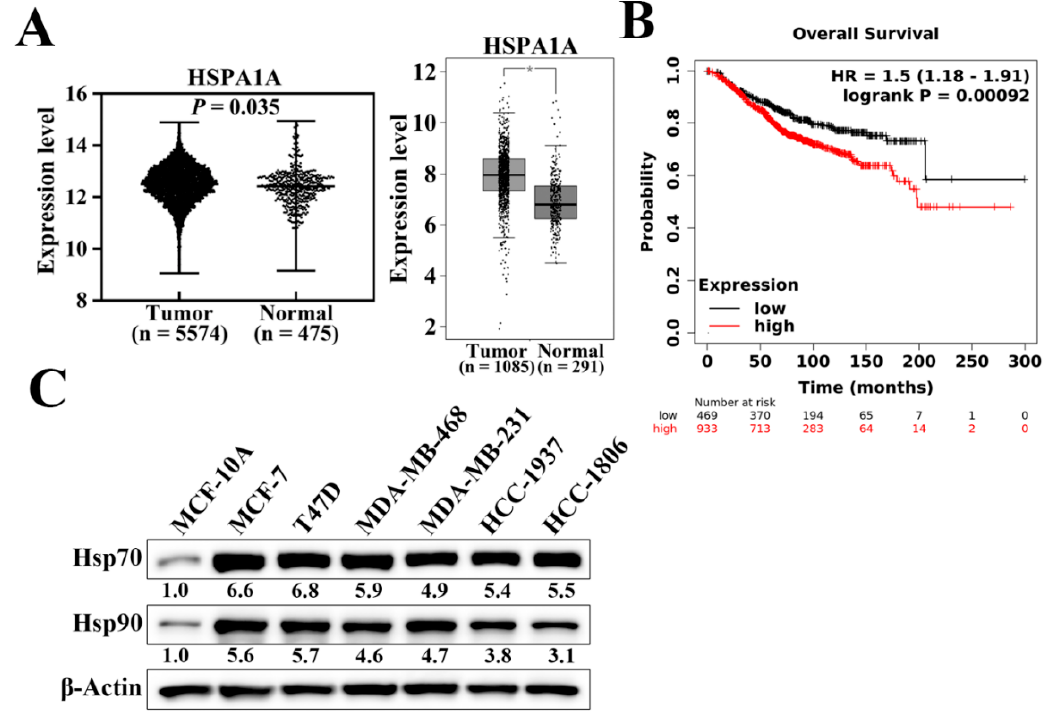
Figure 1. Hsp70 gene and protein expression in clinical breast tissues and breast cancer cells. ( A ) Expression level of Hsp70 in breast cancer (left panel, GENT2 database, n = 5574 in cancerous tissue and n = 481 in normal tissue, p = 0.035; right panel, GEPIA expression database, n = 1085 in cancerous tissue and n = 291 in normal tissue, * p < 0.01). ( B ) Kaplan–Meier analysis of the prognostic value of Hsp70 mRNA expression in the dataset [Affymetrix ID, 202581_at (HSPA1A)]. Survival curves were plotted for all breast cancer patients ( n = 1402). Cut-off value, median expression level. HR, hazard ratio (with 95% confidence interval). ( C ) Differential expression of Hsp70 and Hsp90 proteins in human breast cancer cell lines versus MCF10A normal human mammary cells. Values under Hsp70 and Hsp90 blots represent the relative expression compared to MCF-10A. The band intensity was measured densitometrically using Image J software and normalized to the β -Actin band.